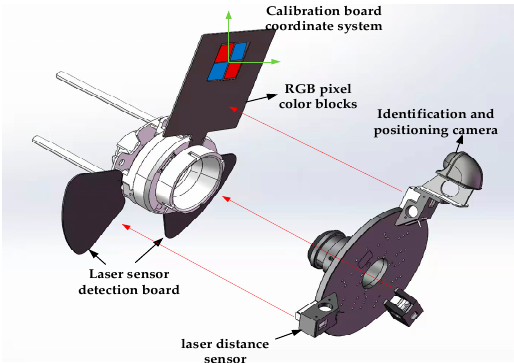
Figure 3. Schematic diagram of visual positioning of the docking system.